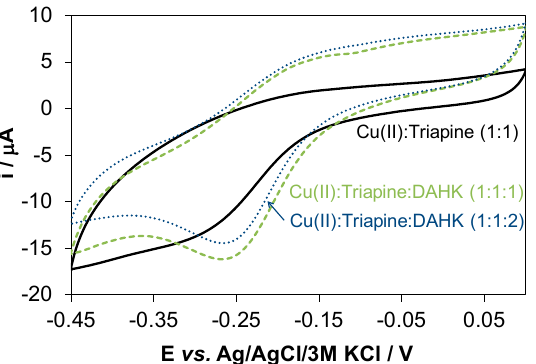
Figure 8. Cyclic voltammograms of the copper(II) ‒ Triapine (1:1) (solid line) and the copper(II) ‒ Triapine ‒ DAHK (1:1:1, dashed line; 1:1:2, dotted line) systems at pH 7.4. { c Cu(II) = c Triapine = 500 μM, c DAHK = 0, 500 or 1000 μM; 30% ( w / w ) DMSO/H 2 O; pH = 7.4 (20 mM HEPES); T = 25 °C; I = 0.10 M (KCl); scan rate: 5 mV/s}.